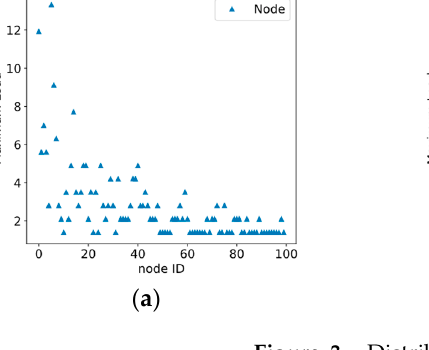
Figure 3. Distribution of the maximum node load when n ≤ 100: ( a ) unsorted; ( b ) sorted; ( c ) schematic diagram of the interval grading algorithm.